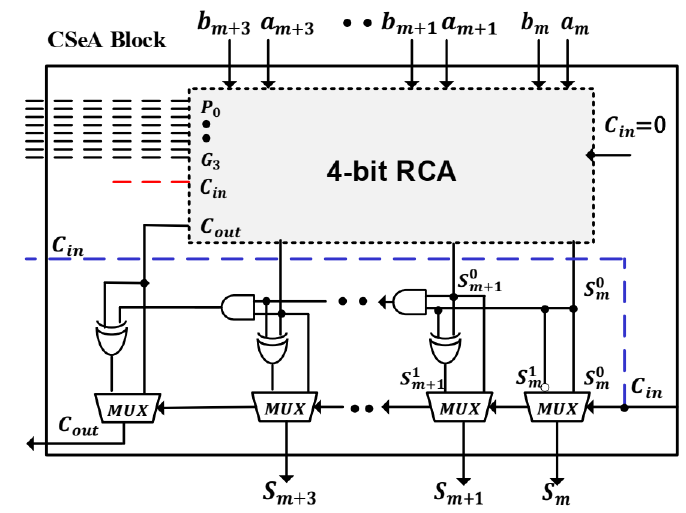
Figure 3. A 4-bit Single adder based CSeA block.